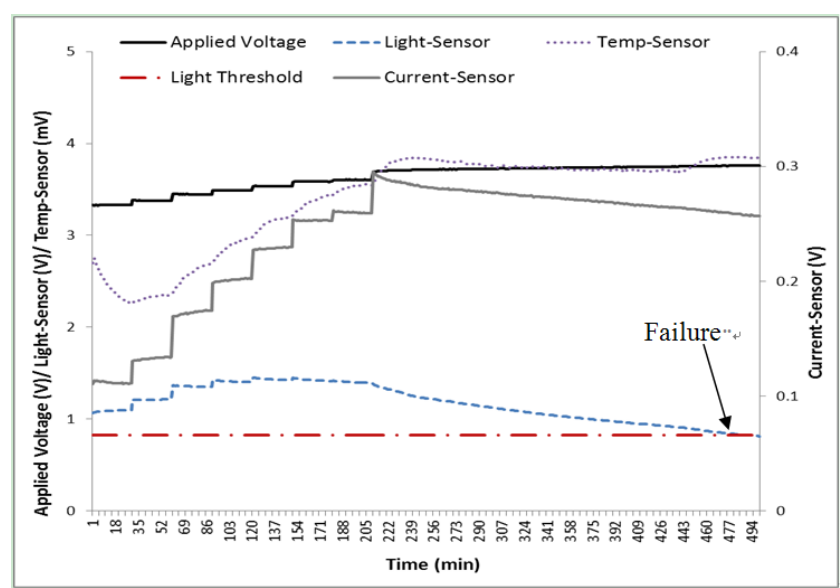
Figure 13. Sensor data from accelerated life test.